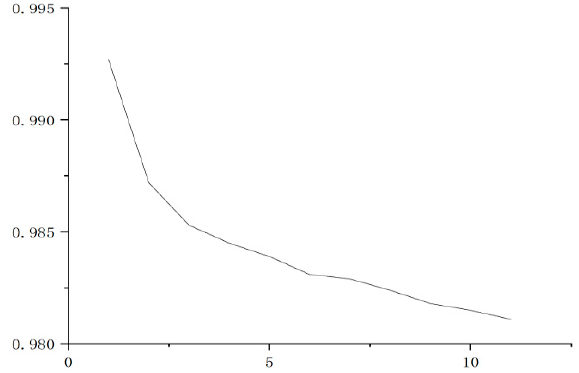
Figure 9. Sample autocorrelation coefficient.